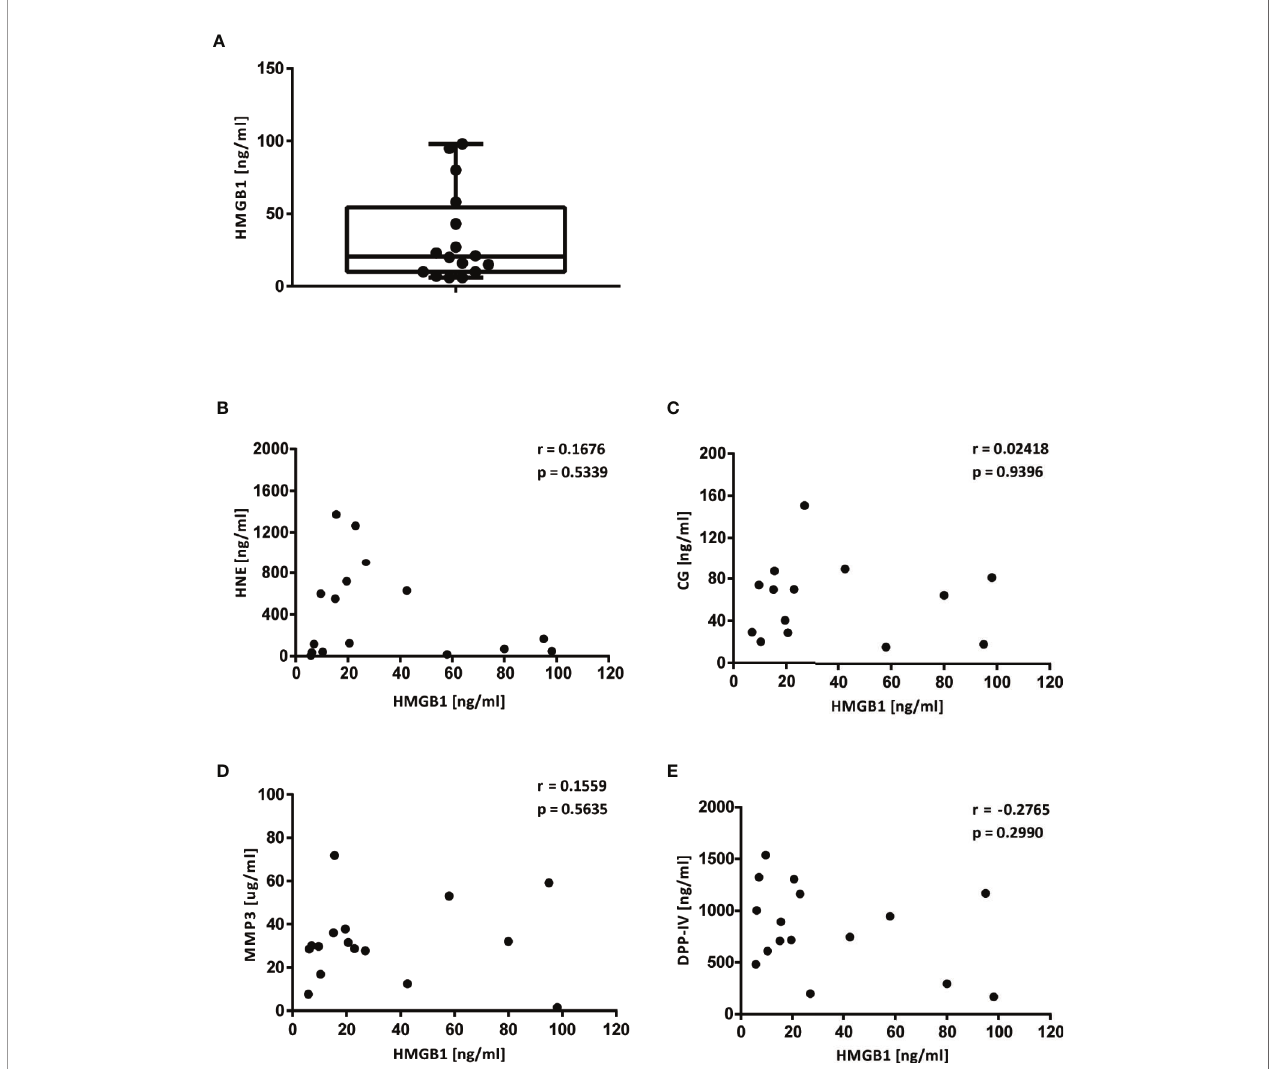
FIGURE 6 | Levels of HMGB1, HNE, CG, MMP3 and DPP-IV in synovial fl uid from JIA patients. Levels of HMGB1 and of the proteases investigated in vitro were de fi ned in 16 synovial fl uid samples from JIA patients. (A) Levels of HMGB1. (B) Levels of HNE. (C) Levels of CG. (D) Levels of MMP3. (E) Levels of DPP-IV. Direct correlations between HMGB1 levels and the level of each protease were assessed by Spearman ’ s correlation